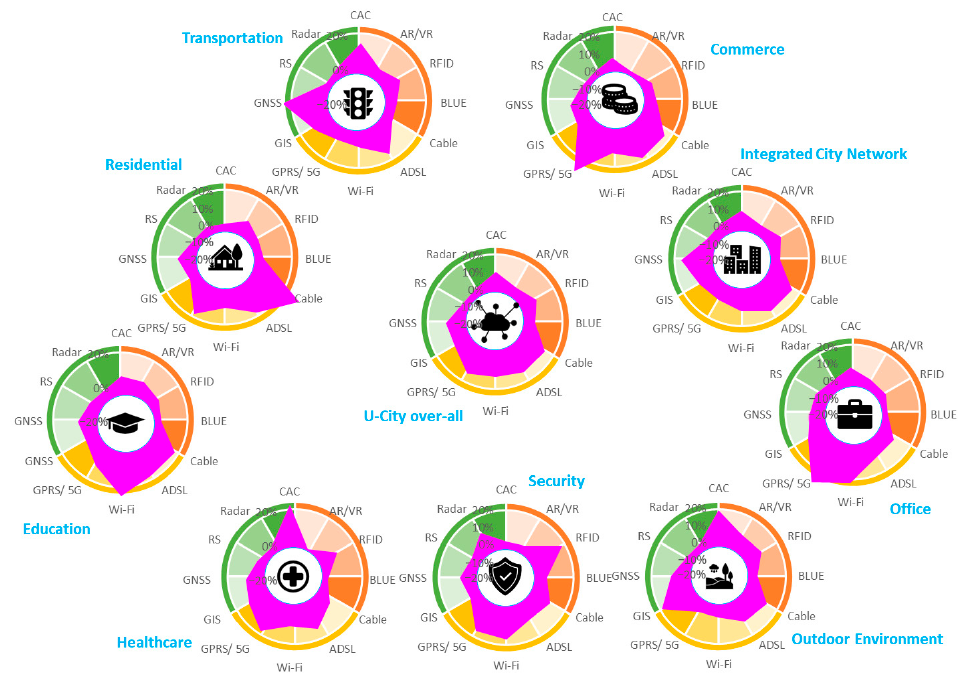
Figure 9. The role of each ICT in the functioning of each service area (exposure of areas).